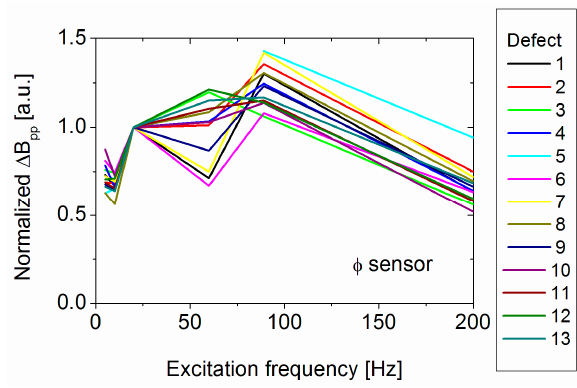
Figure 10. Measured excitation frequency-dependence of the 20 Hz normalized peak-to-peak change in magnetic field amplitude for the Φ -sensor.